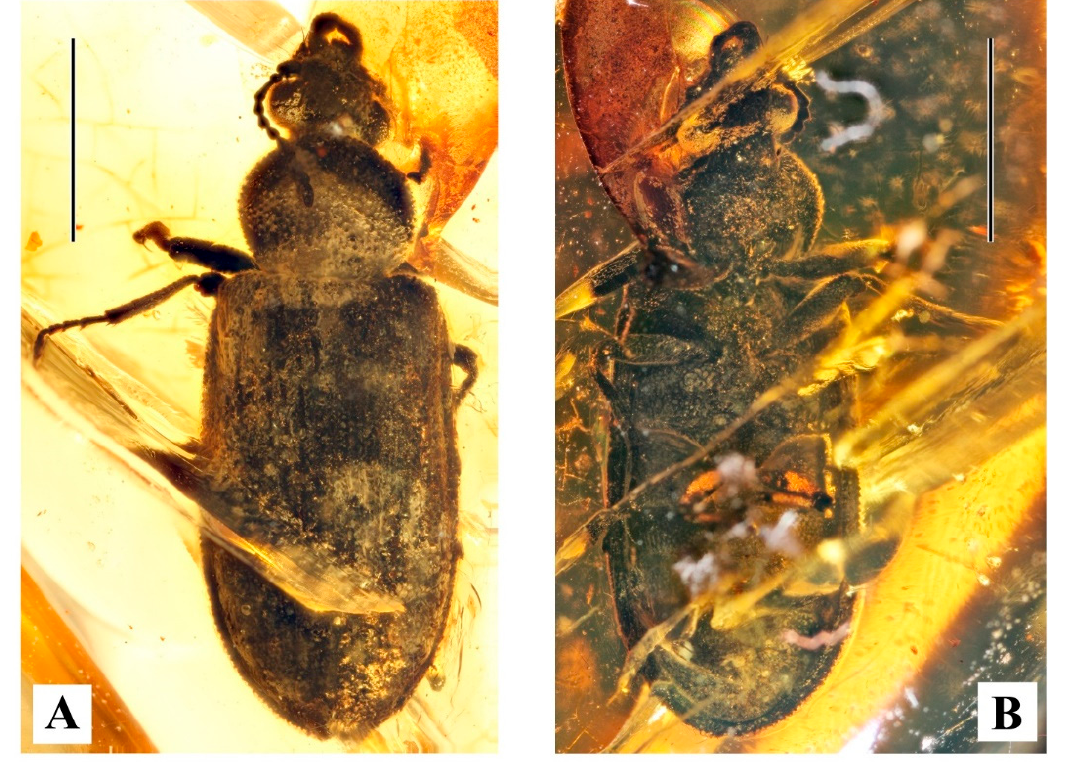
Figure 13. Ommatinae (Cupedidae): Omma janetae sp. nov. , holotype ZIN Cuped 004 (Lower / Upper Cretaceous: Upper Albian / Lower Cenomanian; Myanmar, Kachin, Burmese amber): A —beetle, dorsal, B —same, ventral; length of inclusion 8.6 mm, scale bar for A and B = 2.4 mm; original.